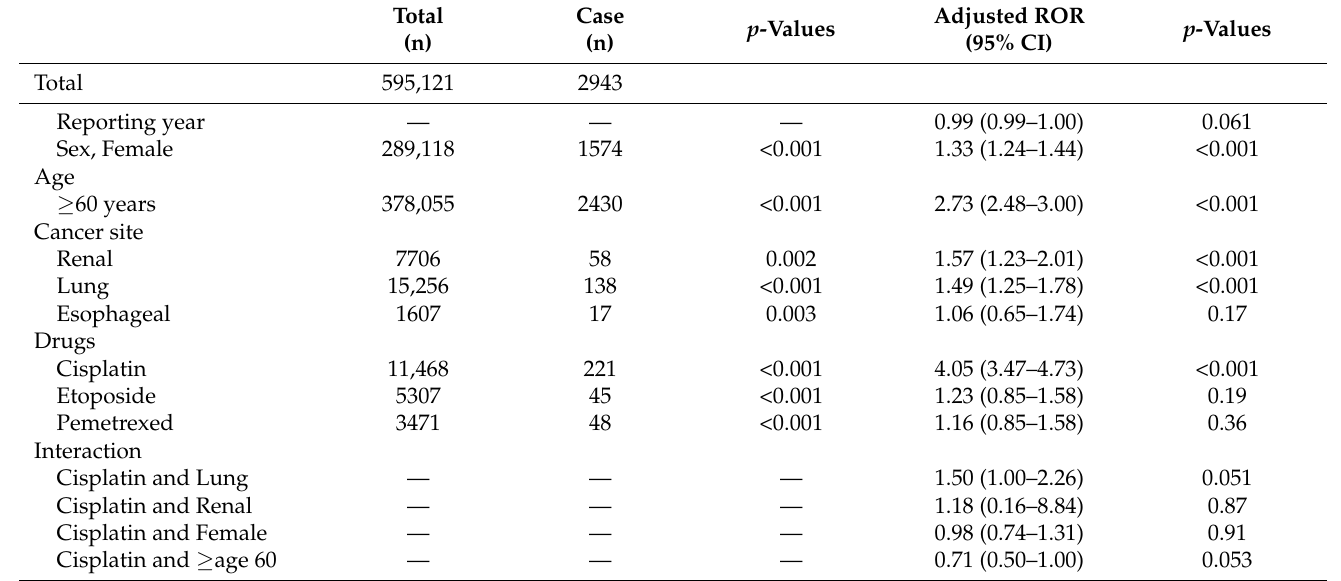
Table 3. The number of reported cases and ROR (95% CI).